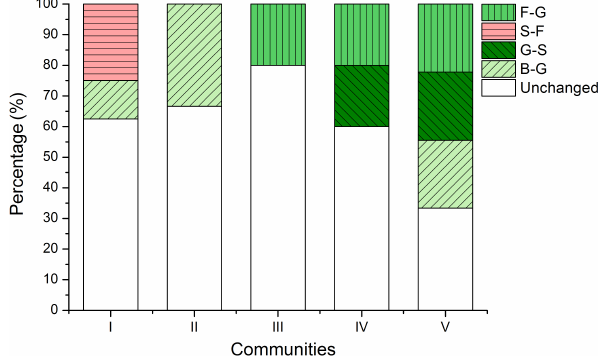
Figure 3. The percent changes of vegetation composition in each community from 2000 to 2014. Note: F–G change from sparse for- est to grassland, S–F change from shrubland to sparse forest, G– S change from grassland to shrubland, and B–G change from bare land to